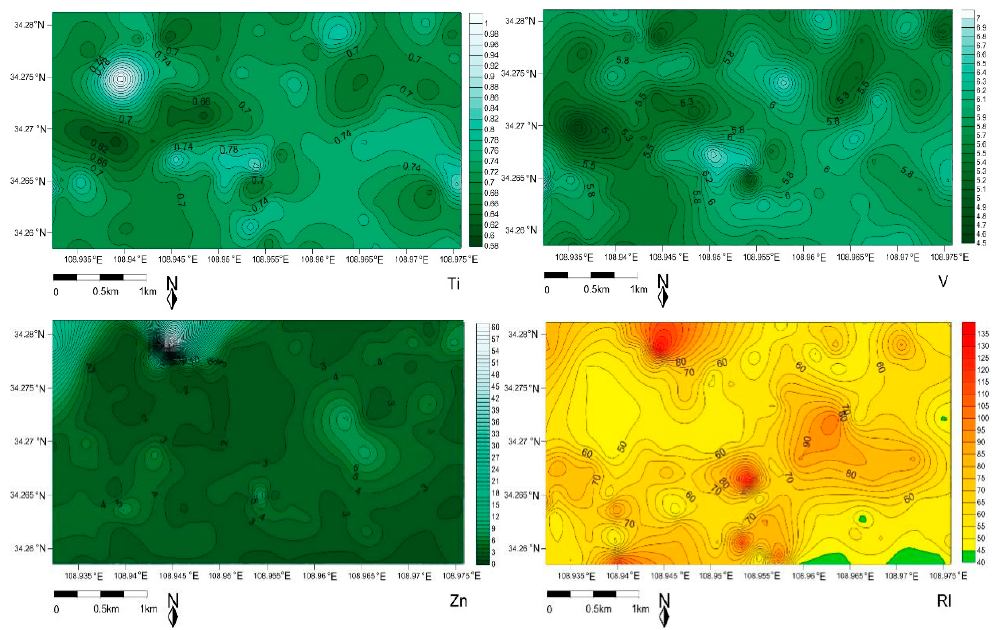
Figure 3. The spatial distribution of potential ecological risk evaluated by the index.